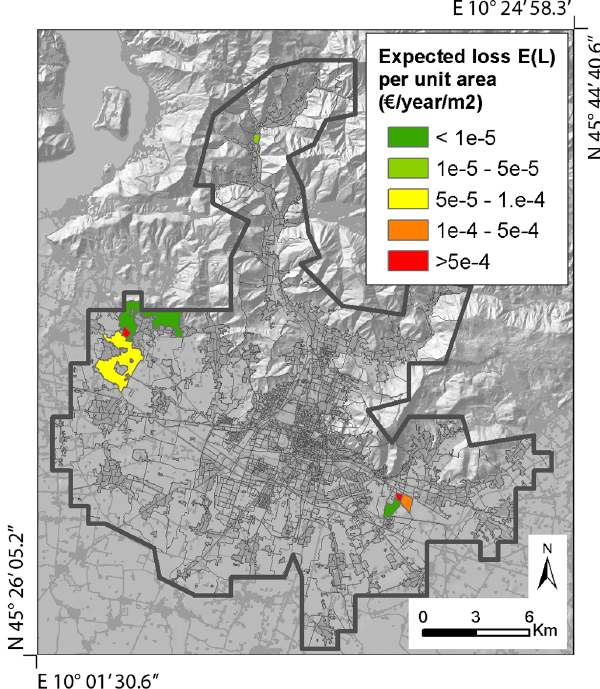
Fig. 12. Industrial economic risk obtained by